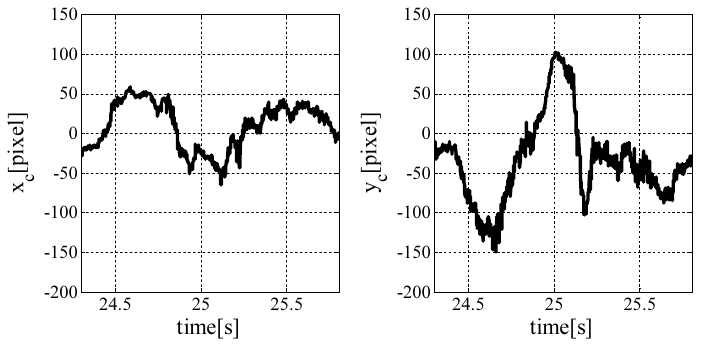
Figure 8. Temporal response of error in image plane [8].